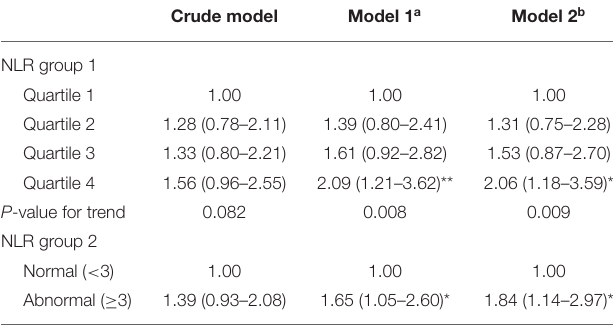
TABLE 3 | Prospective association of NLR with incidence of frailty in robust or pre-frail ( n = 1,206) community-dwelling older adults of the CLHLS study cohort.